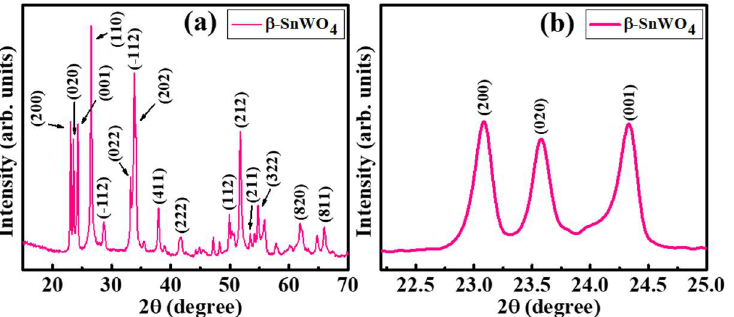
Figure 2. ( a ) Indexed X-ray diffractometer (XRD) pattern and ( b ) magnified image of certain peaks of β-SnWO 4 nanoparticles.